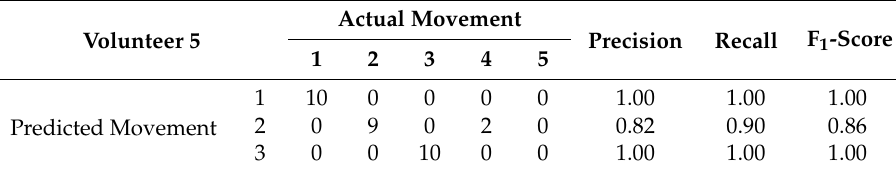
Table A5. Results Volunteer